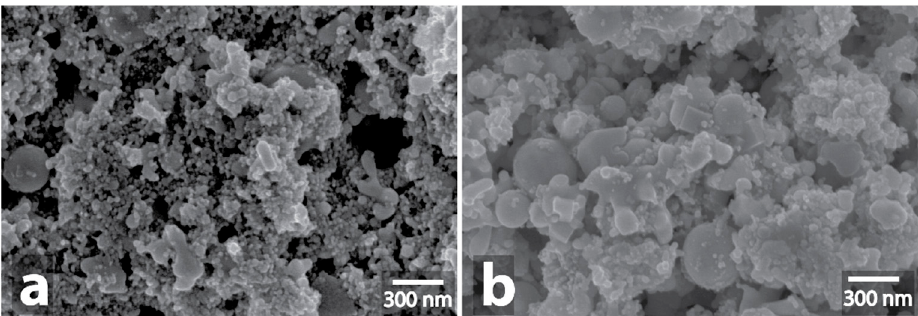
Figure 5. SEM image of initial Re powder ( a ) and SEM image of Re powder after MW-treatment ( b